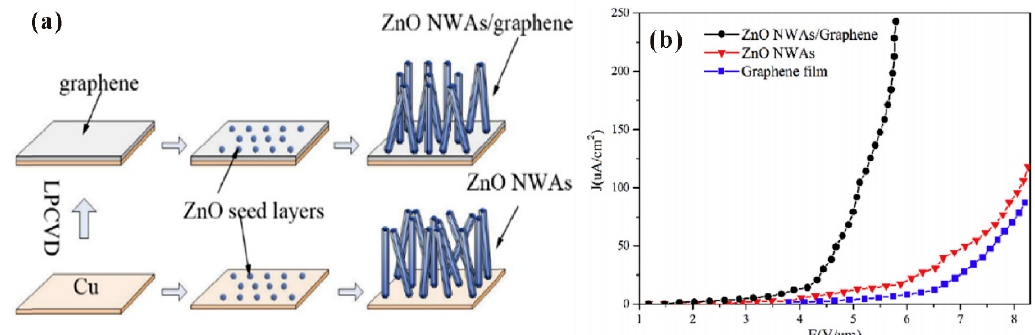
Figure 28. Fabrication procedures ( a ) and field-emission characteristics ( b ) of the ZnO nanowires grown on graphene layer. Reproduced from [102], with the permission of Elsevier, 2016.